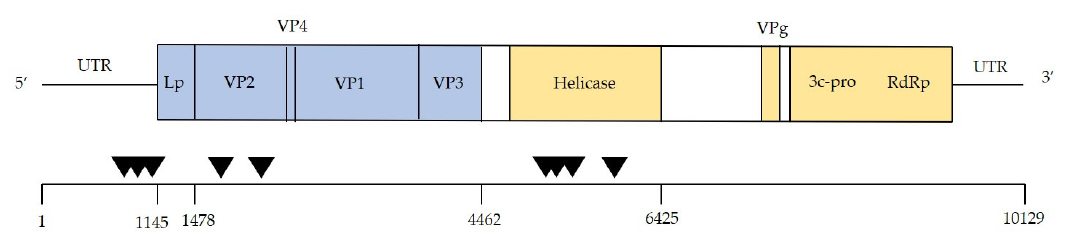
Figure 3. Schematic of the DWV genome showing approximate recombination breakpoints seen in this study denoted by a black triangle. Structural genes are shown in blue and non-structural genes in yellow. Nucleotide positions are shown according the DWV-A genome.